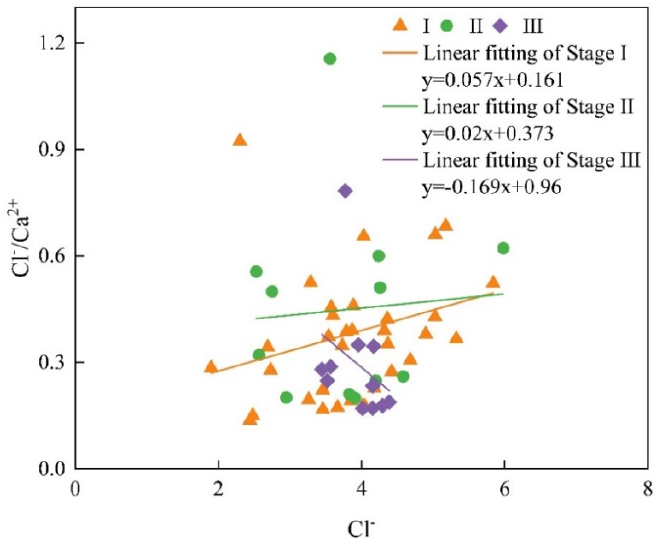
Figure 13. Analysis of karst groundwater hydrodynamic conditions in Taiyuan Formation.